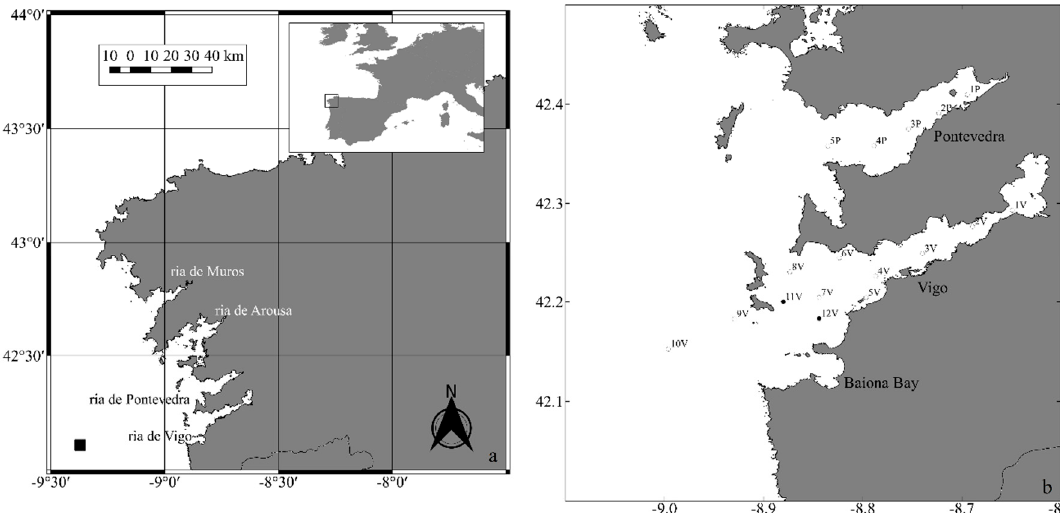
Figure 1. ( a ) Map of the Galician coast. From north to south the rias Baixas: Muros y Noya, Arousa, Pontevedra and Vigo. The location of the Seawatch buoy station off Cabo Silleiro is shown by a black rectangle. ( b ) Map of Ria de Vigo and Ria de Pontevedra showing the locations of the sampling stations.